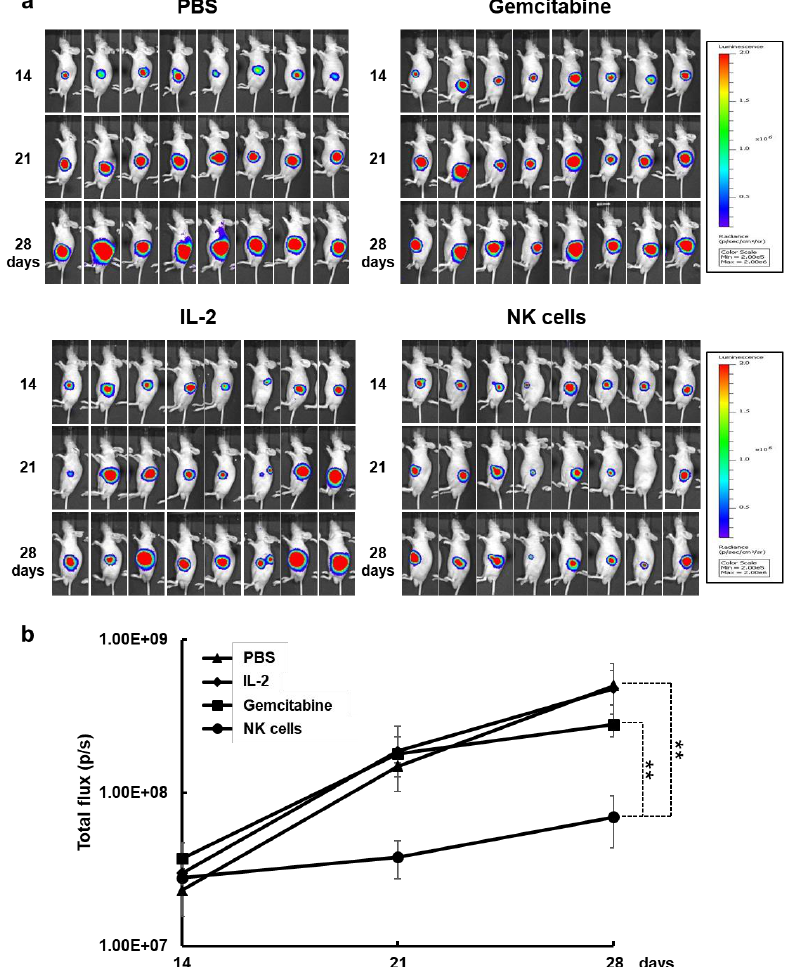
Figure 6. Therapeutic efficacy of natural killer (NK) cells in a MIA PaCa-2 orthotopic pancreatic tumor model. Orthotopic pancreatic tumor models were established by injecting firefly luciferase-expressing MIA PaCa-2 cells (5 × 10 6 ) into the pancreas of nude mice. At 14 days after tumor cell injection, 2 × 10 7 NK cells three times a week for 2 weeks or gemcitabine at 100 mg/kg twice a week for 2 weeks was intraperitoneally administered. ( a ) Bioluminescence whole body imaging was monitored every 7 days following the treatments. ( b ) Bioluminescence signals were calculated after background subtraction in total flux photons/sec from a body region of interest. These images are representatives from three independent experiments. Data presented as mean ± standard deviation (SD); ** p < 0.01.